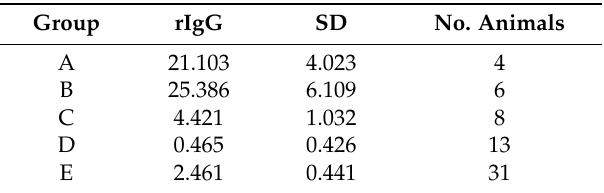
Table A8. This table shows all data used to generate Figure 3E as well as the number of animals included in the study. p -values are shown in Table A7A.